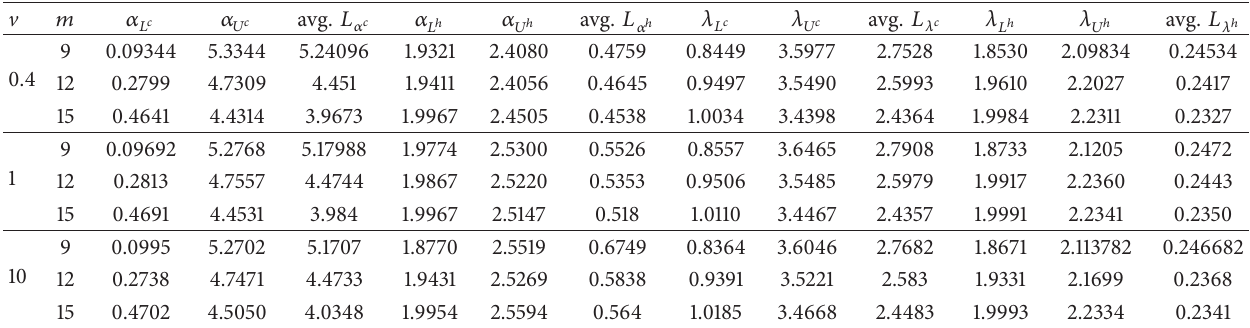
Table 5: 95% CI and HPD for different sample 𝑚 and prior variances V for fixed 𝑛 = 15 , 𝛼 = 2 , and 𝜆 = 2